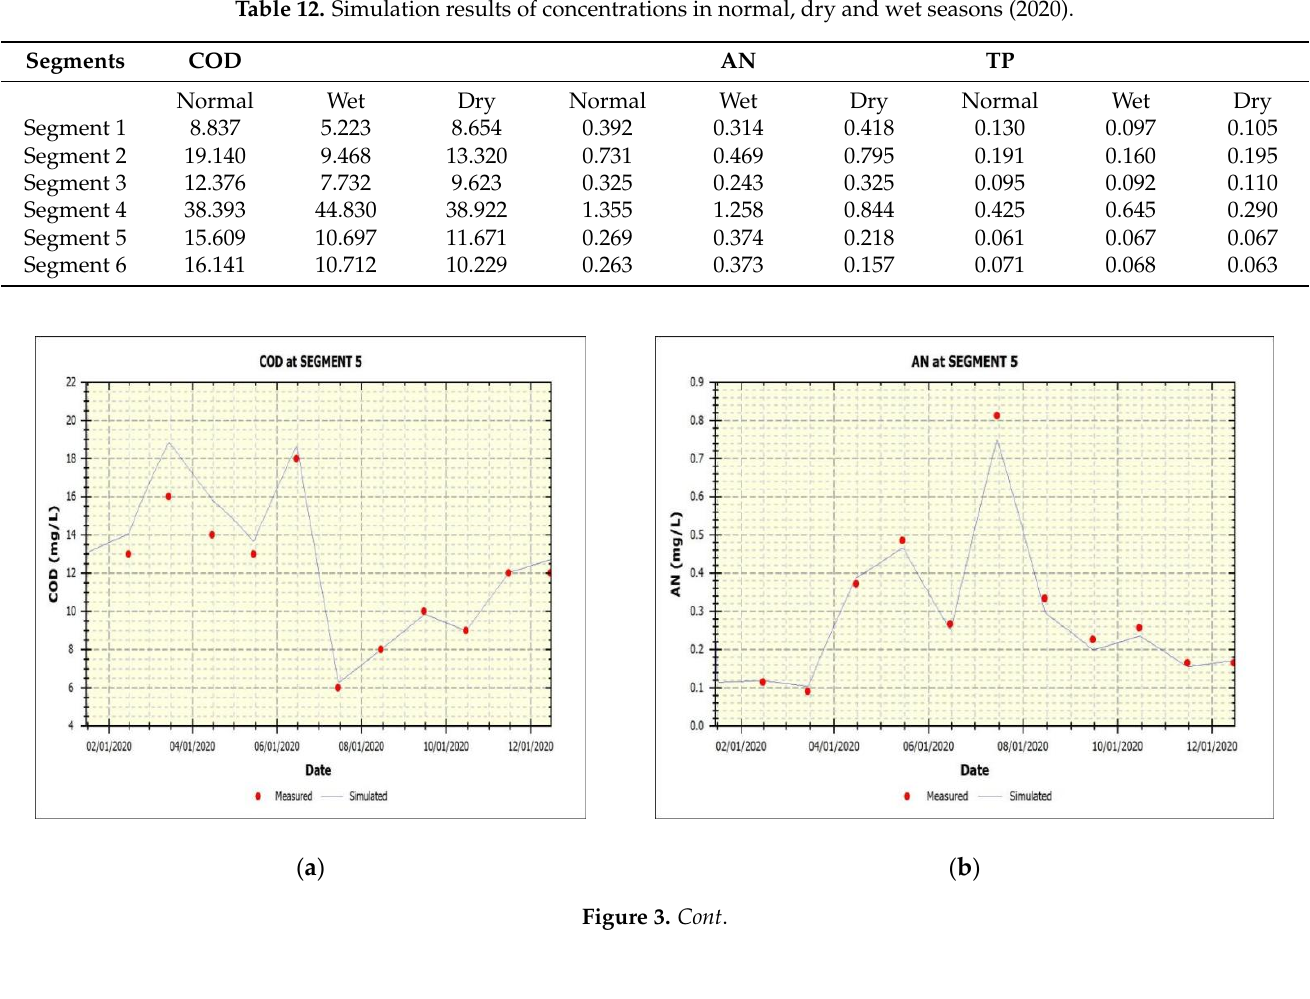
Table 12. Simulation results of concentrations in normal, dry and wet seasons (2020).